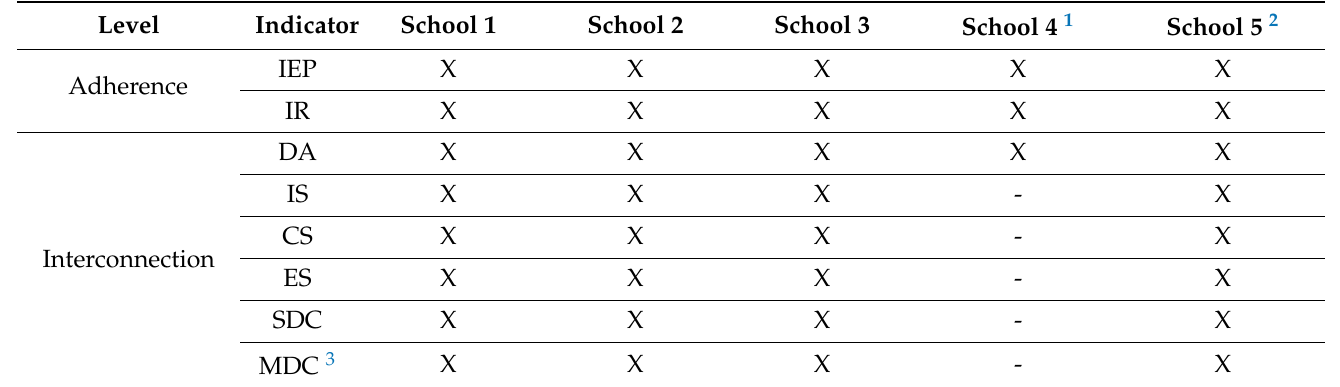
Table 1. Materials used in research